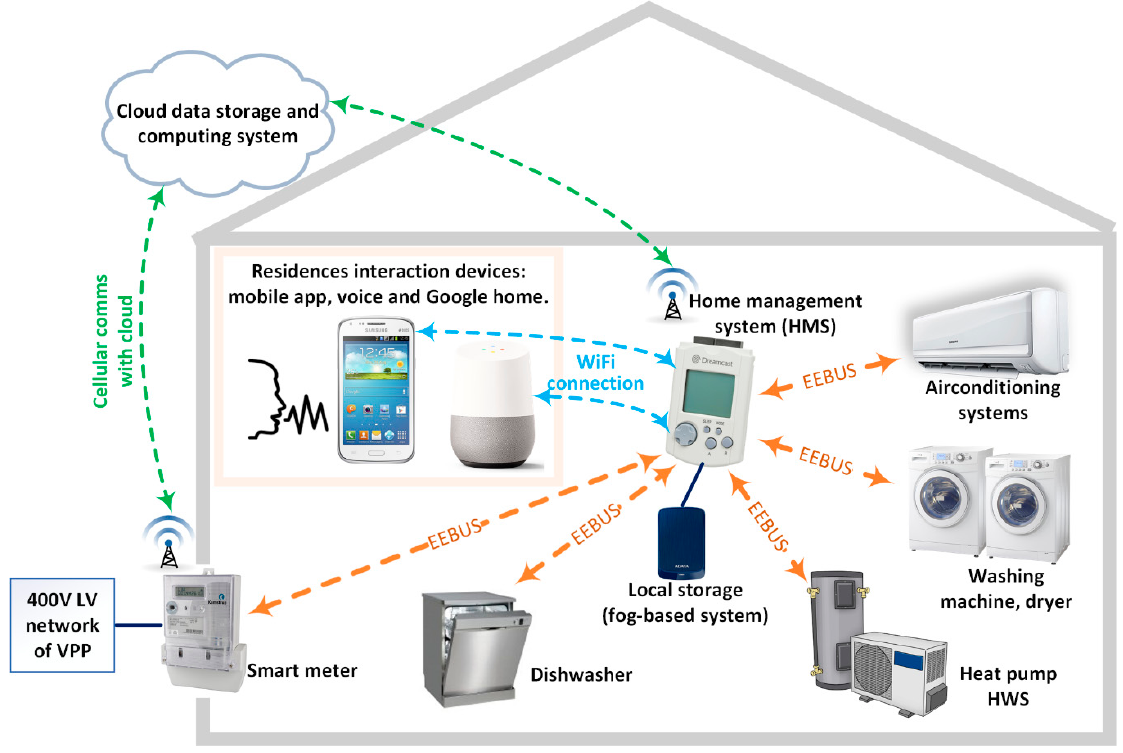
Figure 4. The proposed configuration of the monitoring and control system within each dwelling in the VPP. HWS: hot water system.